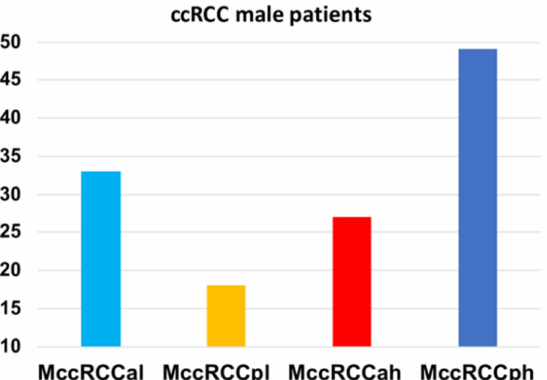
Figure 3. Bar charts showing the distribution of ccRCC male patients in the four categories. Note the greater number of male patients with collateral vessels and high Fuhrman grades. Shown are patients with an absence of collateral vessels and low Fuhrman grades (ccRCCal); the presence of collateral vessels and low Fuhrman grades (ccRCCpl); an absence of collateral vessels and high Fuhrman grades (ccRCCah); and the presence of collateral vessels and high Fuhrman grades (ccRCCph). Non-significant results ( p = 0.13) were found by sub-grouping patients with ccRCC and peritumoral collateral vessels according to the median value (i.e., 7.2 cm) of tumor size (low Furhman grade and size < median n = 20; low Furhman grade and size >